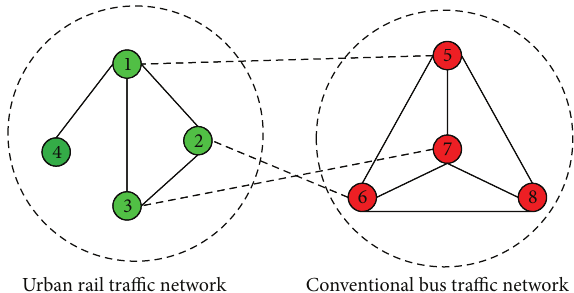
Figure 1: The topology map of urban public traffic